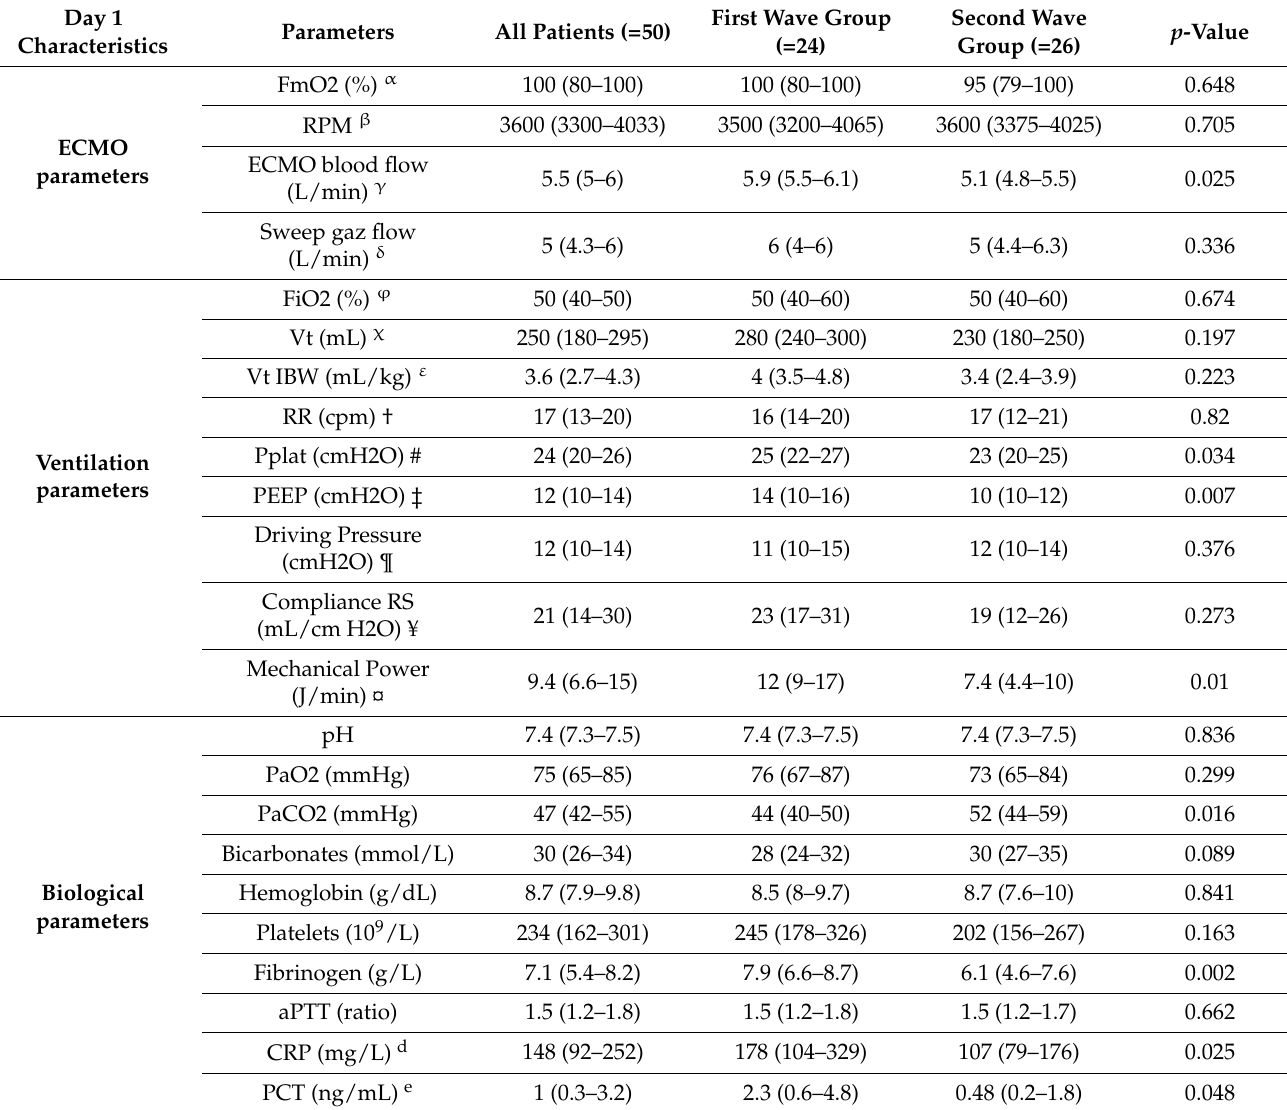
Table 3. ECMO, ventilation, and biological parameters at veno-venous extracorporeal membrane oxygenation (V-V ECMO) day one in the first and second wave